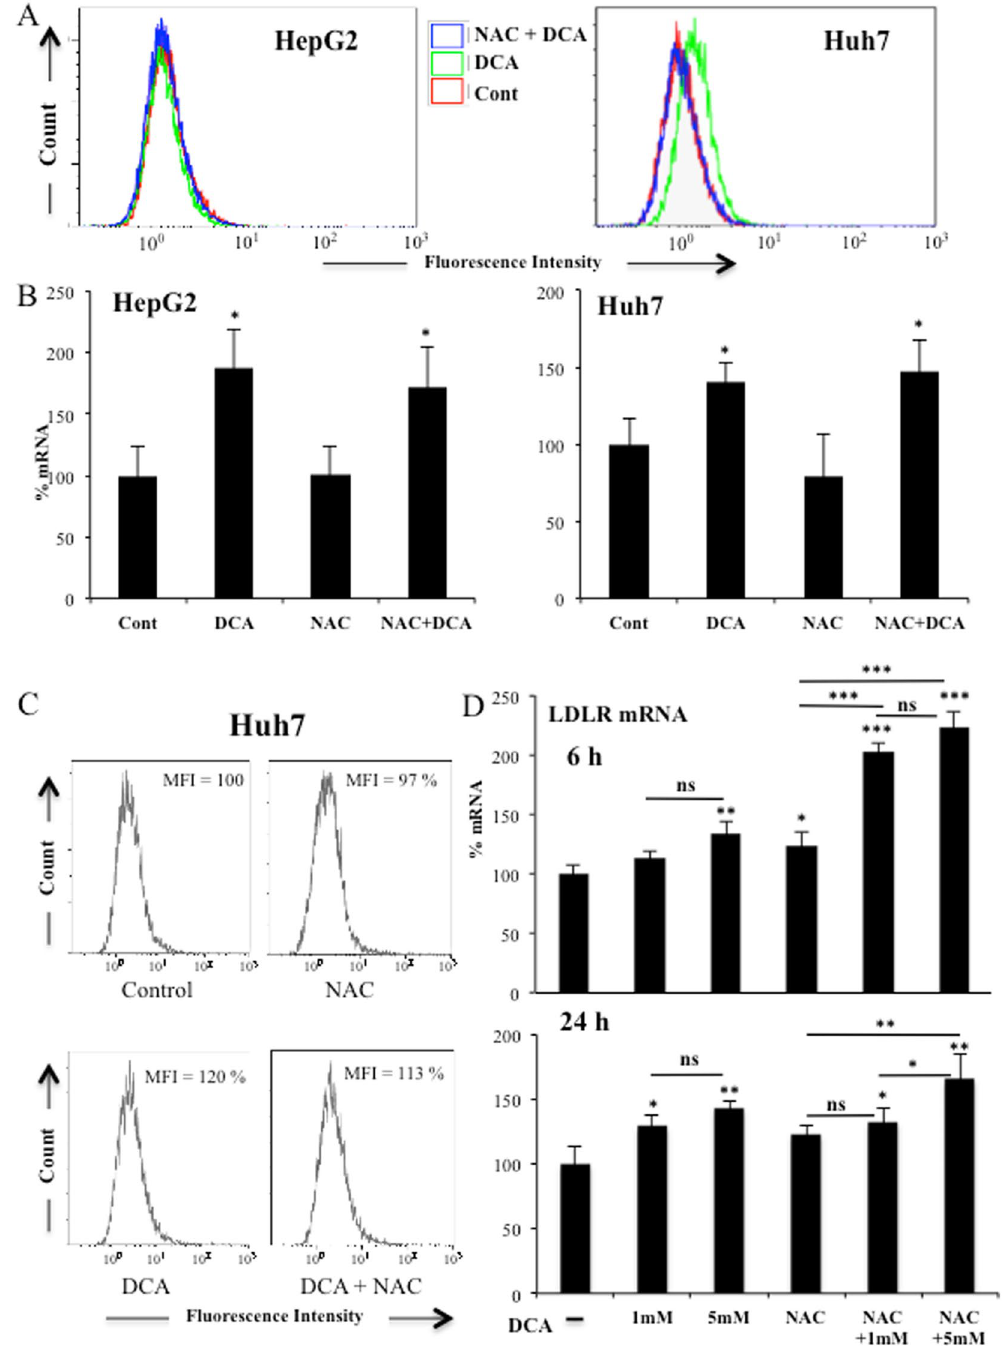
Figure 3. Increase in ROS levels was not required for LDLR expression. ( A ) Both hepatic cell lines were treated with 2 mM NAC 1 h before adding DCA (10 mM) for 24 h. Cells were labeled with CH-H2DCFDA and analyzed by FACs for ROS production. LDLR mRNA ( B ) or protein ( C ) from these cells were analyzed as described in Fig. 1. Results represent the means ± SD of these donors with experiments performed in triplicate. The data represent means ± SD; * p < 0.05, ** p < 0.01, *** p < 0.005 student t-test compared to cells non treated with DCA. D) Primary hepatocytes from 2 independent donors were treated for 6 and 24 h as in ( A ) but with two different DCA concentrations before analyzing LDLR mRNA expression. The data represent means ± SD; * p < 0.05, ** p < 0.01, *** p < 0.005 one-way ANOVA with post-hoc Tukey